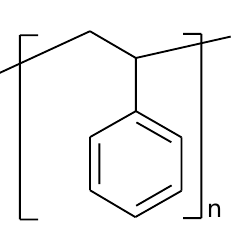
Figure 3. The fragment of polystyrene structure.